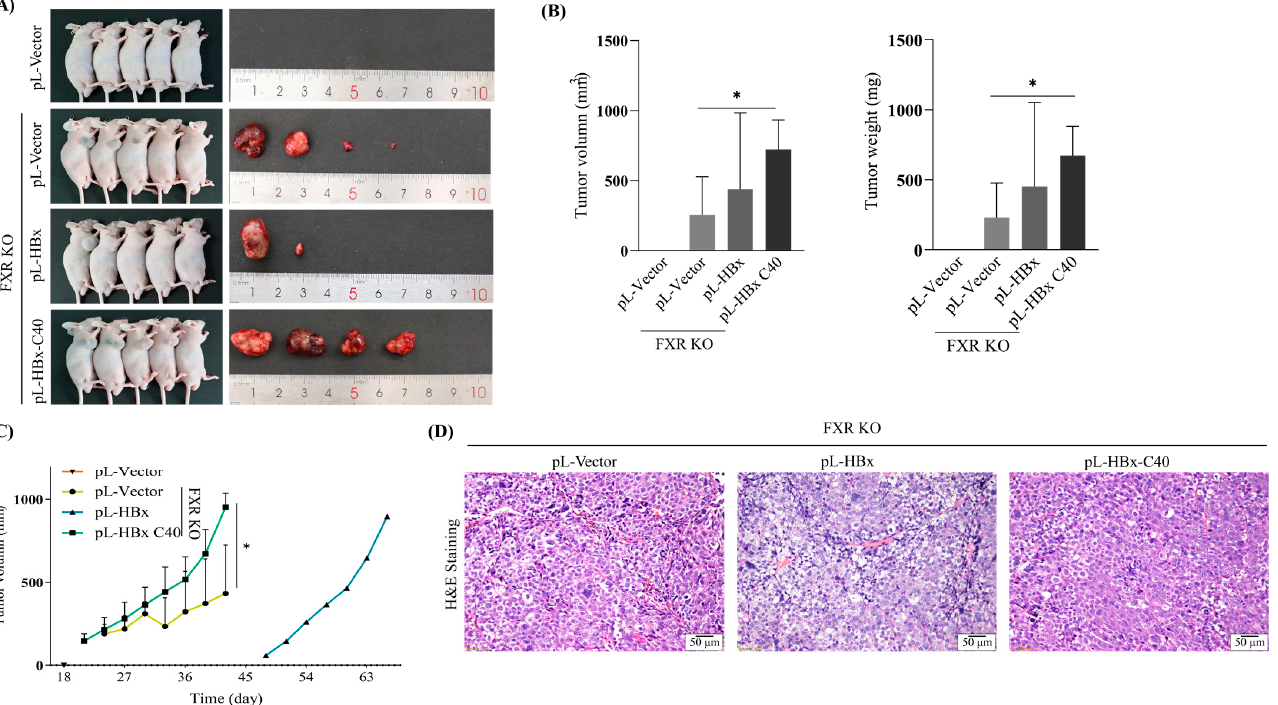
Figure 5. HBx C40 promotes tumorigenesis in FXR KO Hep3B cells in vivo. ( A ) Image of grafted tumors in nude mice following injection of NC, FXR KO, FXR KO + HBx, and FXR KO + HBx C40 Hep3B cells. ( B , C ) Tumor growth of each group of mice was recorded every 3 days. ( D ) Representative H&E staining of tumors in the NC, FXR KO, FXR KO + HBx, and FXR KO + HBx C40 groups is shown. The data represent the mean of the sample. Scale bar = 50 μ m. * p < 0.05.